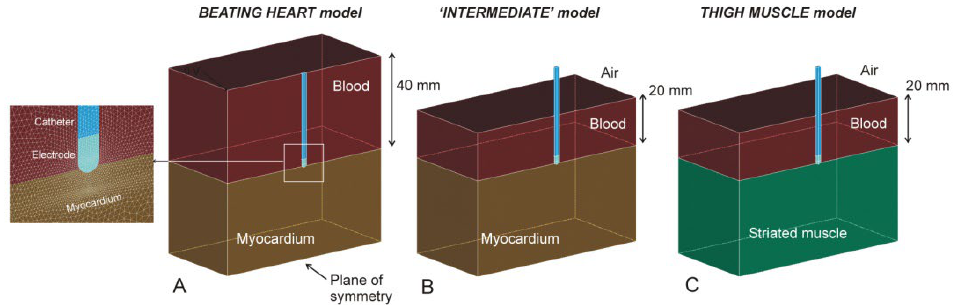
Figure 1. Geometries of models of myocardium ( A ), thigh muscle ( C ) and ‘intermediate’ ( B ) (see text for details). The figures are those of the case of a perpendicular catheter.